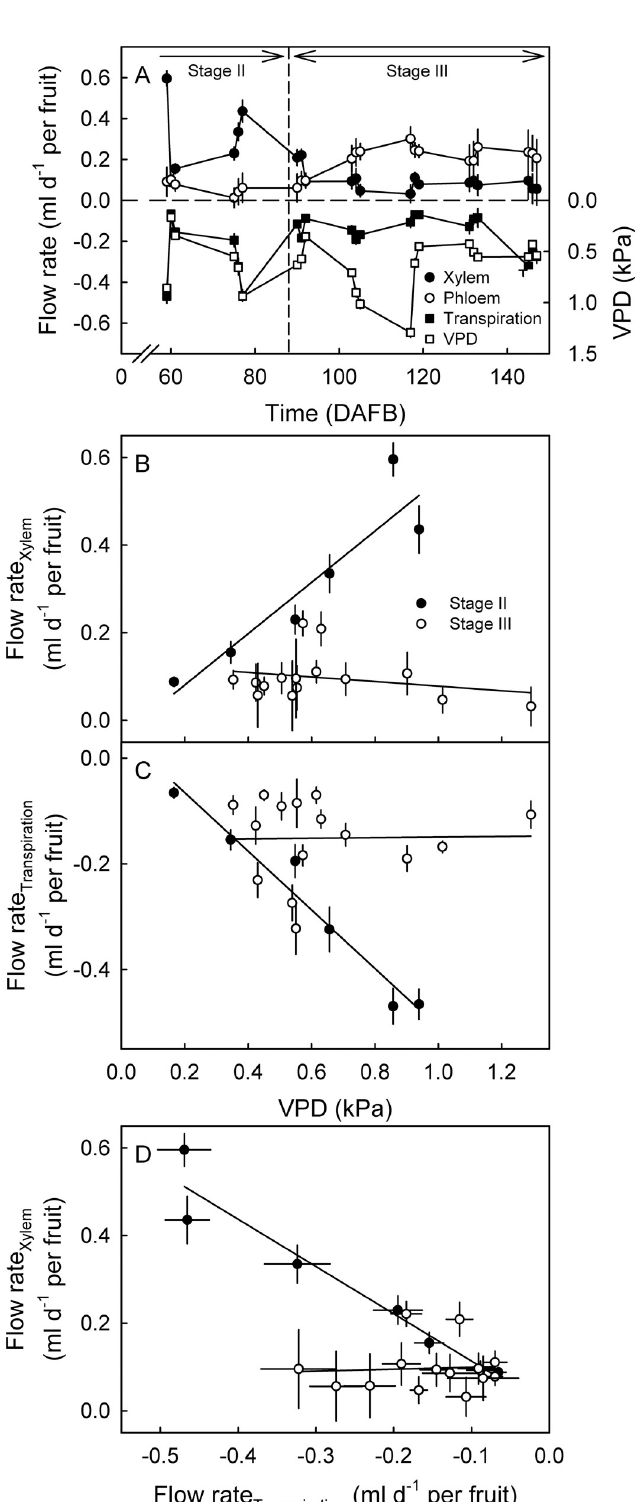
Fig 5. (A) Developmental time course of the water flow rates through the skin (transpiration) and through the pedicel (xylem and phloem) of fruit of European plum. Values of atmospheric water vapor pressure deficit (VPD) are provided for comparison. (B) Xylem flow rates and (C) transpiration flow rates as affected by VPD. (D) Relationship between xylem flow rate and transpiration flow rate. The vertical dashed line in A indicates the stage II/III transition.